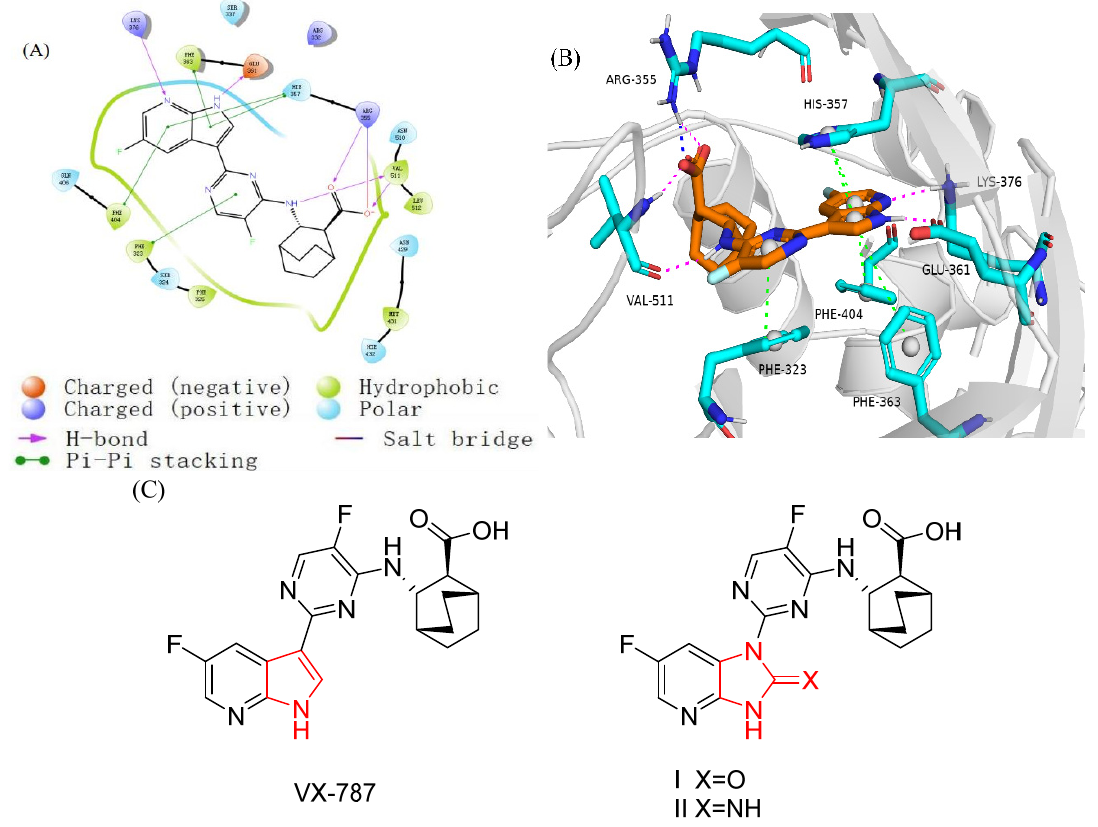
Figure 2. The 2D representation ( A ) and 3D summary ( B ) of the interaction analysis results of the binding mode of VX-787 to PB2, given by the crystal structure of the PB2/VX-787 protein complex (PDB 5WL0). The π – π stacking interaction is shown as a green dashed line, the intermolecular hydrogen bond as a magenta dashed line, and the salt bridge as a blue dashed line. ( C ) Structures of VX-787 and the designed comp. I and comp. II .